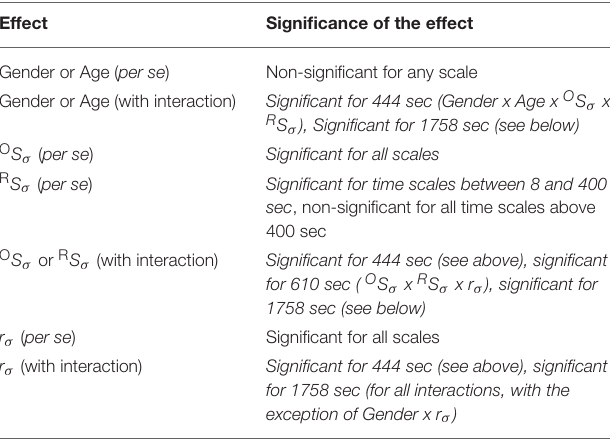
TABLE 2 | Homogeneity of Slopes Model/Separate Slopes Model/Covariance analysis